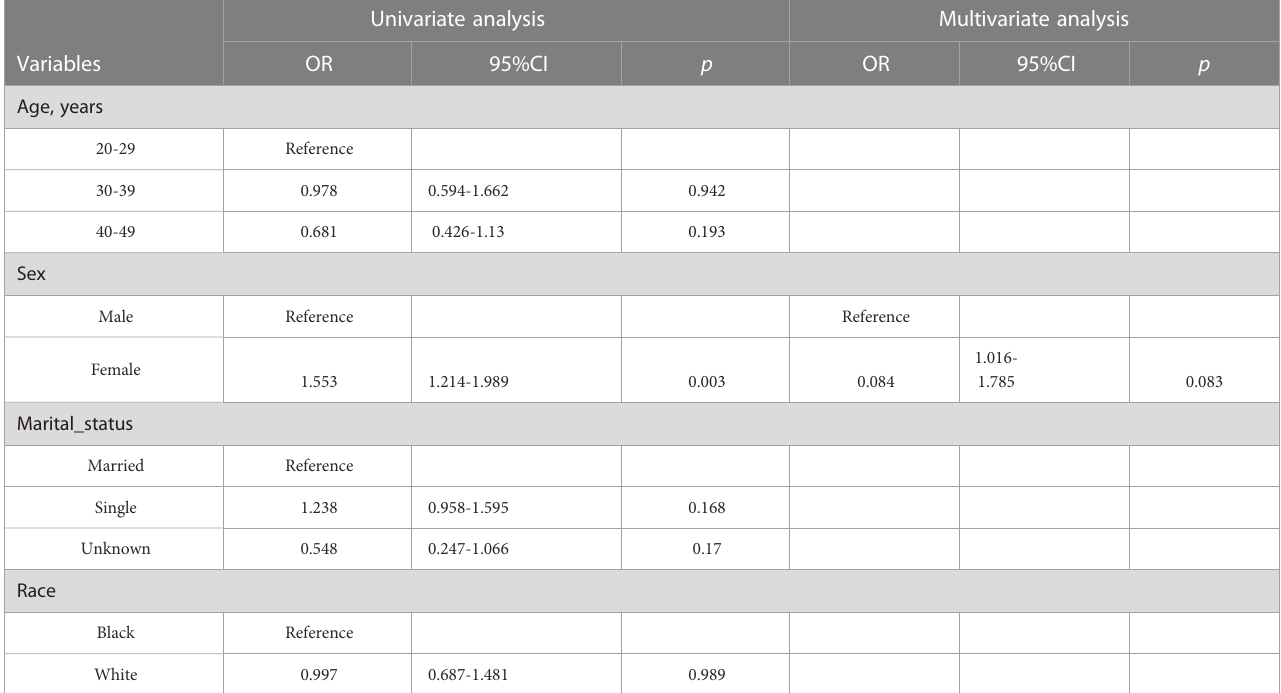
TABLE 3 Univariate and multivariate logistic regression analyses of distant metastasis in early-onset gastric cancer from training set. Univariate analysis Multivariate analysis Variables OR 95%CI